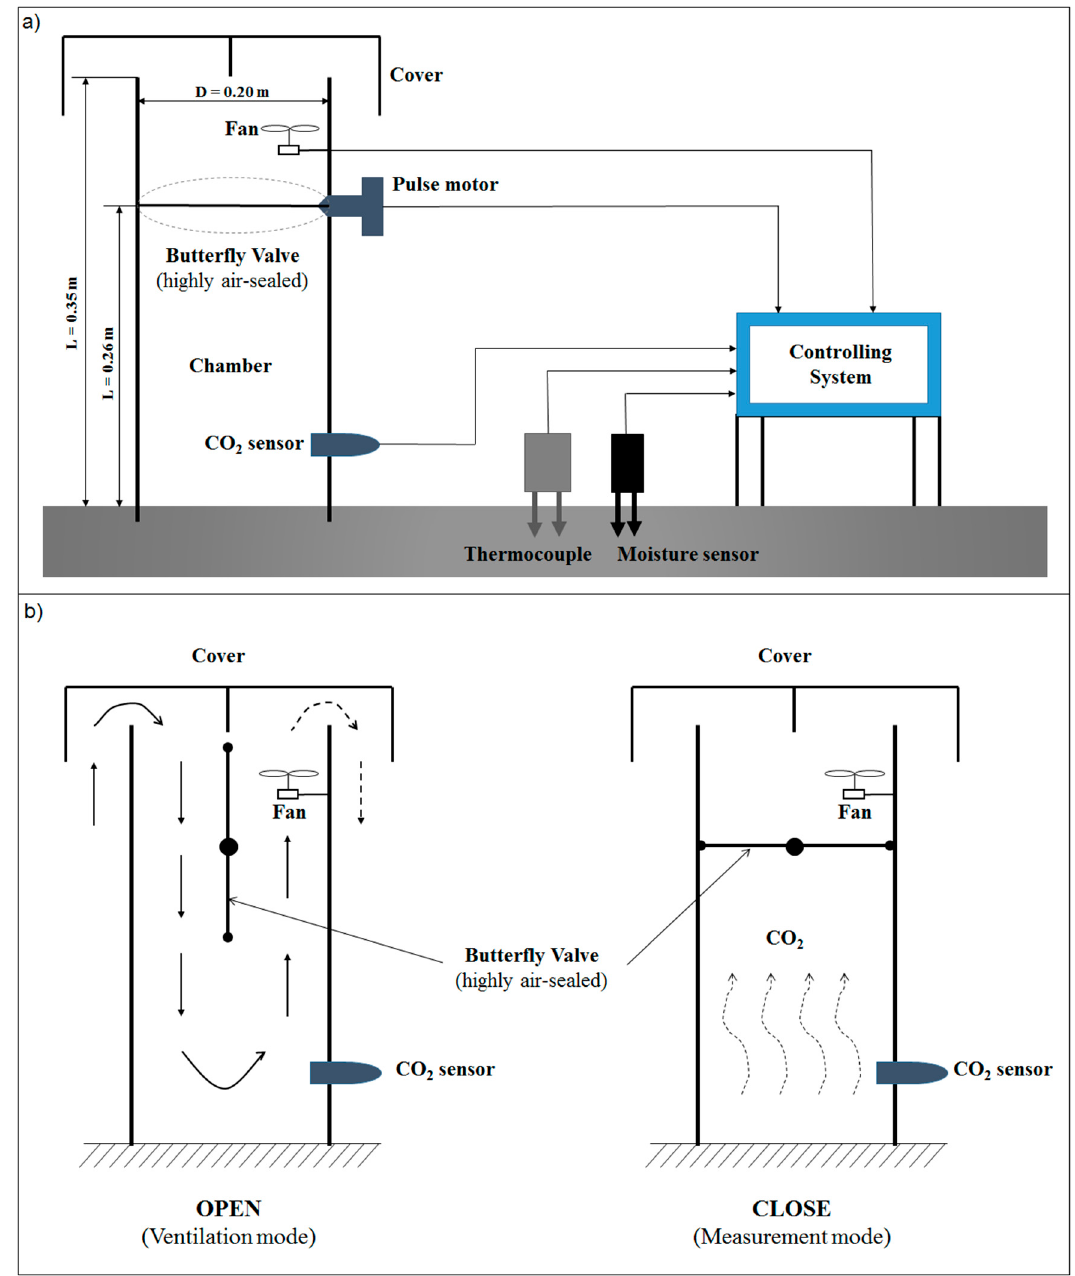
Figure 2. System for measuring soil CO 2 flux using a closed-chamber method including a) schematic diagram of the system and b) operational stages using a butterfly valve in the measurement cycle.